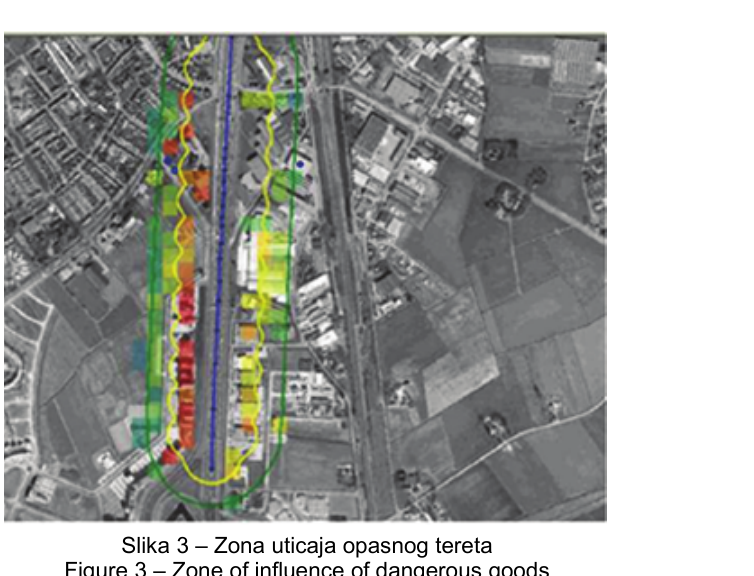
Figure 3 – Zone of influence of dangerous